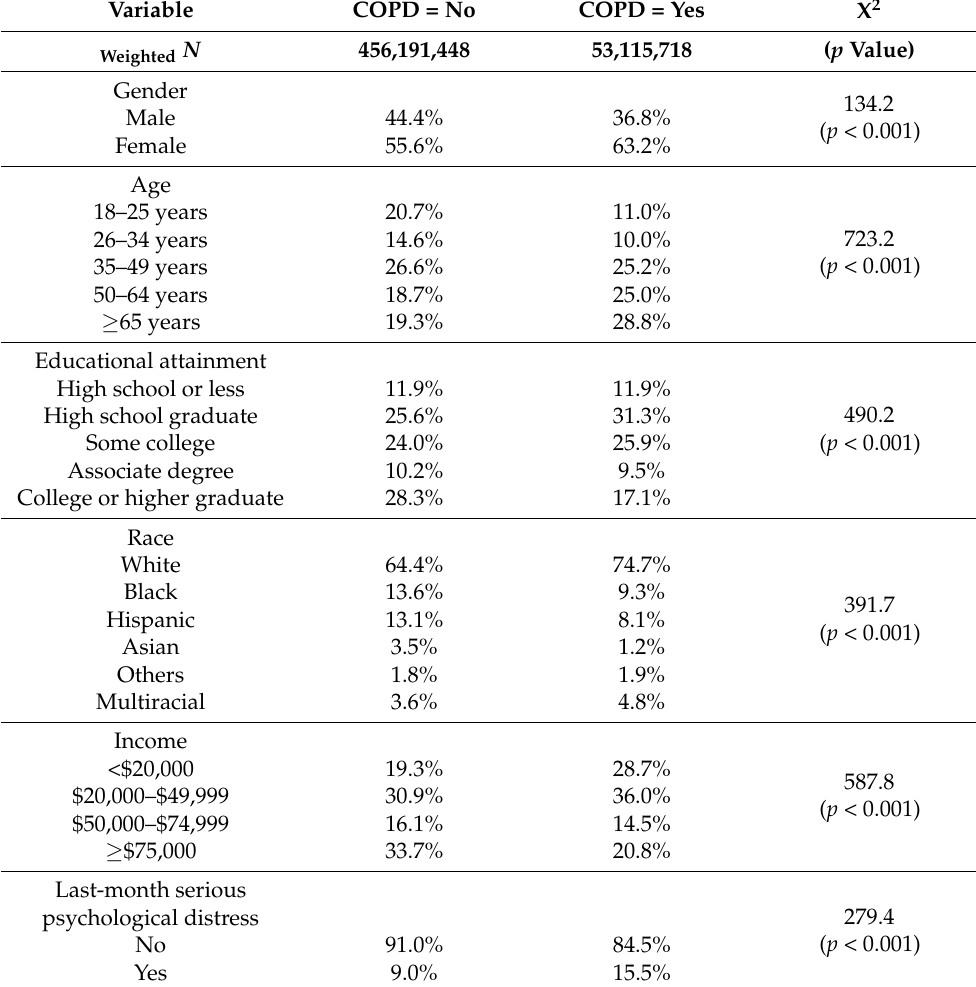
Table 1. Weighted sociodemographic characteristics of adults with